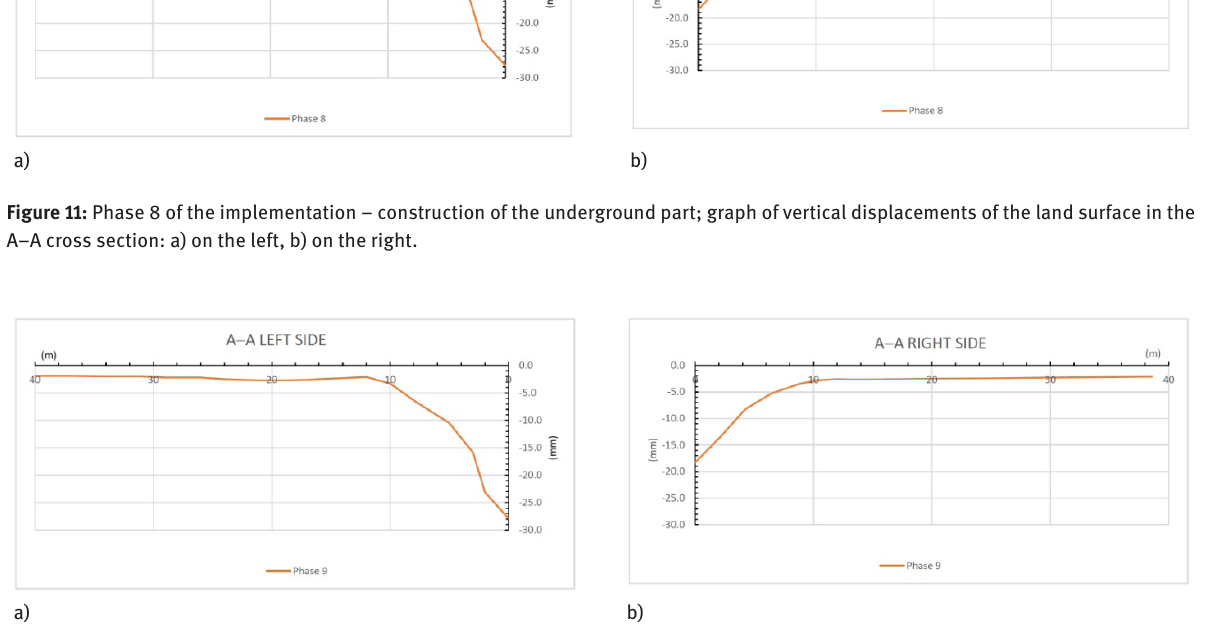
Figure 12: Phase 9 of the implementation – construction of the above-ground part; graph of vertical displacements of the land surface in the A–A cross section: a) on the left, b) on the right.